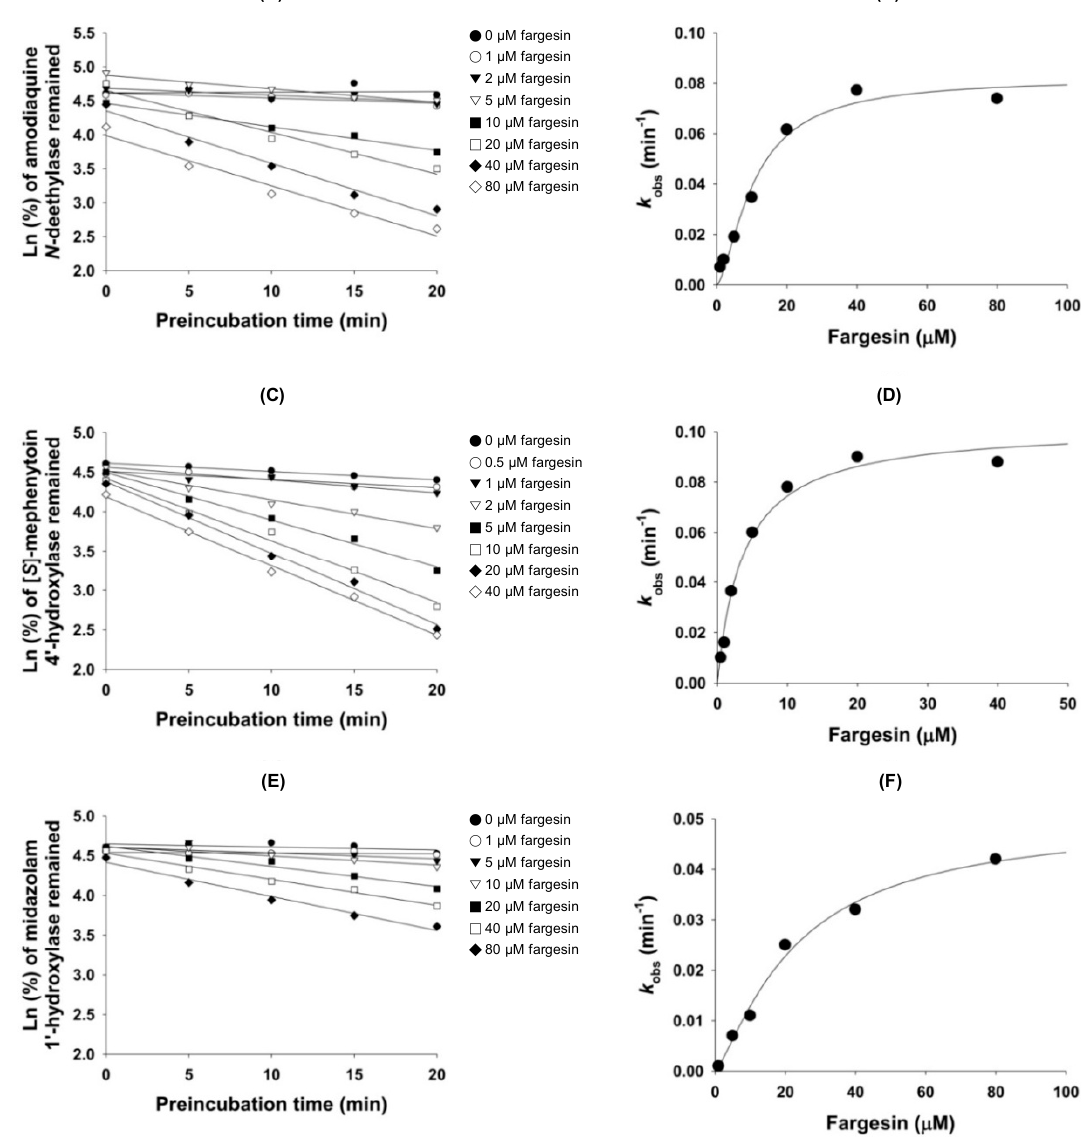
Figure 8. ( A ) Inactivation of human liver microsomal formation of N -desethylamodiaquine from amodiaquine by various fargesin concentrations; ( B ) The relationship between the observed k ( k obs ) and fargesin concentration for the estimation of the K i and k inact values of CYP2C8-catalyzed amodiaquine N -deethylation; ( C ) Inactivation of human liver microsomal formation of 4’-hydroxy-[ S ]-mephenytoin from [ S ]-mephenytoin by various fargesin concentrations; ( D ) The relationship between k obs and fargesin concentration for the estimation of the K i and k inact values of CYP2C19-catalyzed [ S ]-mephenytoin 4’-hydroxylation; ( E ) Inactivation of human liver microsomal formation of 1’-hydroxymidazolam from midazolam by various fargesin concentrations; and ( F ) The relationship between the k obs and fargesin concentration for the estimation of the K i and k inact values of CYP3A4-catalyzed midazolam 1’-hydroxylation. Fargesin exhibited competitive inhibition of CYP2C9-catalyzed diclofenac 4’-hydroxylation ( K i , 16.3 μ M), but aschantin showed mechanism-based inhibition of CYP2C9 ( K i , 3.7 μ M; k inact , 0.044 min − 1 ) [32]. Other pharmacologically active lignans such as honokiol, deoxypodophyllotoxin, and podophyllotoxin potently inhibited CYP2C9 activity with K i values of 0.54, 3.5, and 2.0 μ M, respectively [33,36,38].